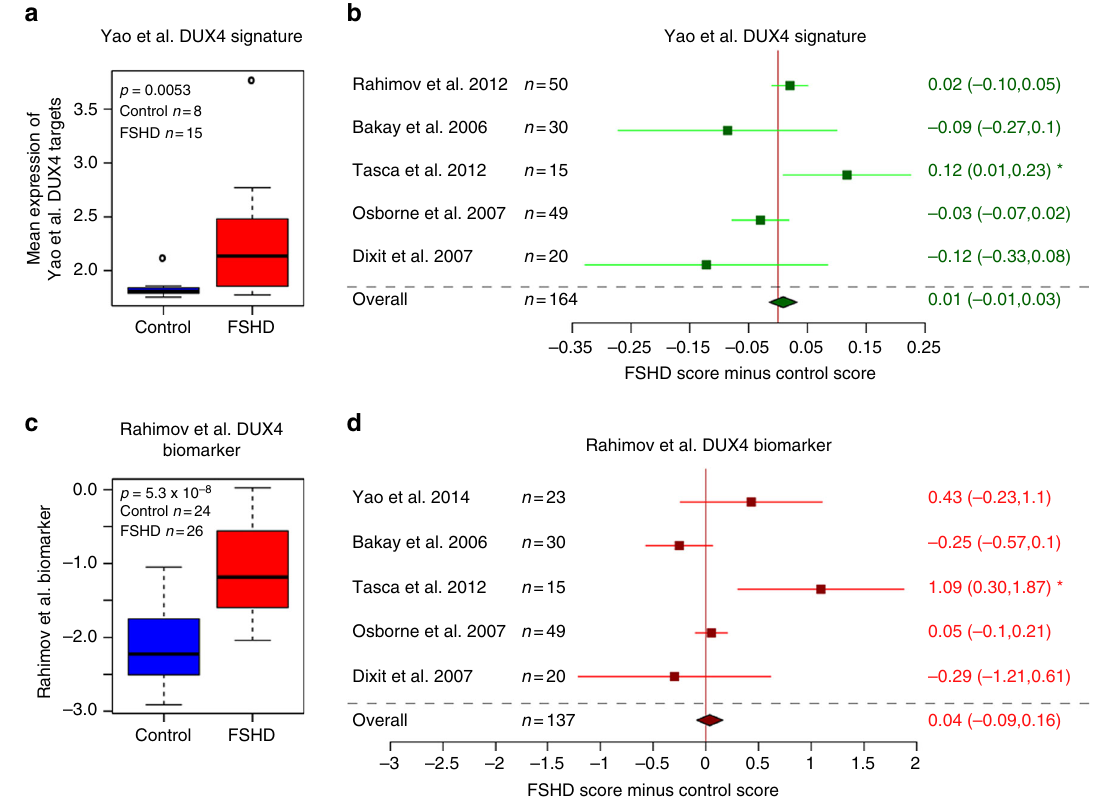
Fig. 1 Reported FSHD biomarkers do not validate on most published FSHD muscle biopsy gene expression data sets. a Box plot con fi rms that the Yao et al. 10 DUX4 114 target gene signature validates as a biomarker on the RNA-seq FSHD muscle biopsy data set published by Yao et al. 10 . The box represents the interquartile range (IQR), with the median indicated by a line. Whiskers denote min (1.5*IQR, max (observed value)). ‘‘ o ’’ represents data points greater than 1.5 IQR from the median, n = 15 FSHD and n = 8 control muscle biopsies. b A forest plot displays the results of meta-analysis of the discriminatory power of the Yao et al. 10 DUX4 target gene signature across fi ve published microarray FSHD muscle biopsy data sets (in total n = 82 FSHD and n = 82 control muscle biopsies). The differential scores (FSHD score minus control score) alongside 95% con fi dence intervals are provided. c A box plot con fi rms that the Rahimov et al. 3 FSHD 15 gene biomarker validates as a biomarker on the microarray FSHD muscle biopsy discovery data set published by Rahimov et al. 3 . The box represents the interquartile range (IQR), with the median indicated by a line. Whiskers denote min (1.5*IQR, max (observed value)). ‘‘ o ’’ represents data points greater than 1.5 IQR from the median, n = 26 FSHD and n = 24 control muscle biopsies. d A forest plot displays the results of meta-analysis of the discriminatory power of the Rahimov et al. 3 FSHD biomarker across four published microarray and one RNA-seq FSHD muscle biopsy data sets (in total n = 71 FSHD and n = 66 control muscle biopsies). The differential scores (FSHD score minus control score) alongside 95% con fi dence intervals are provided. Neither biomarker is able to discriminate FSHD from control samples on meta-analysis. However,